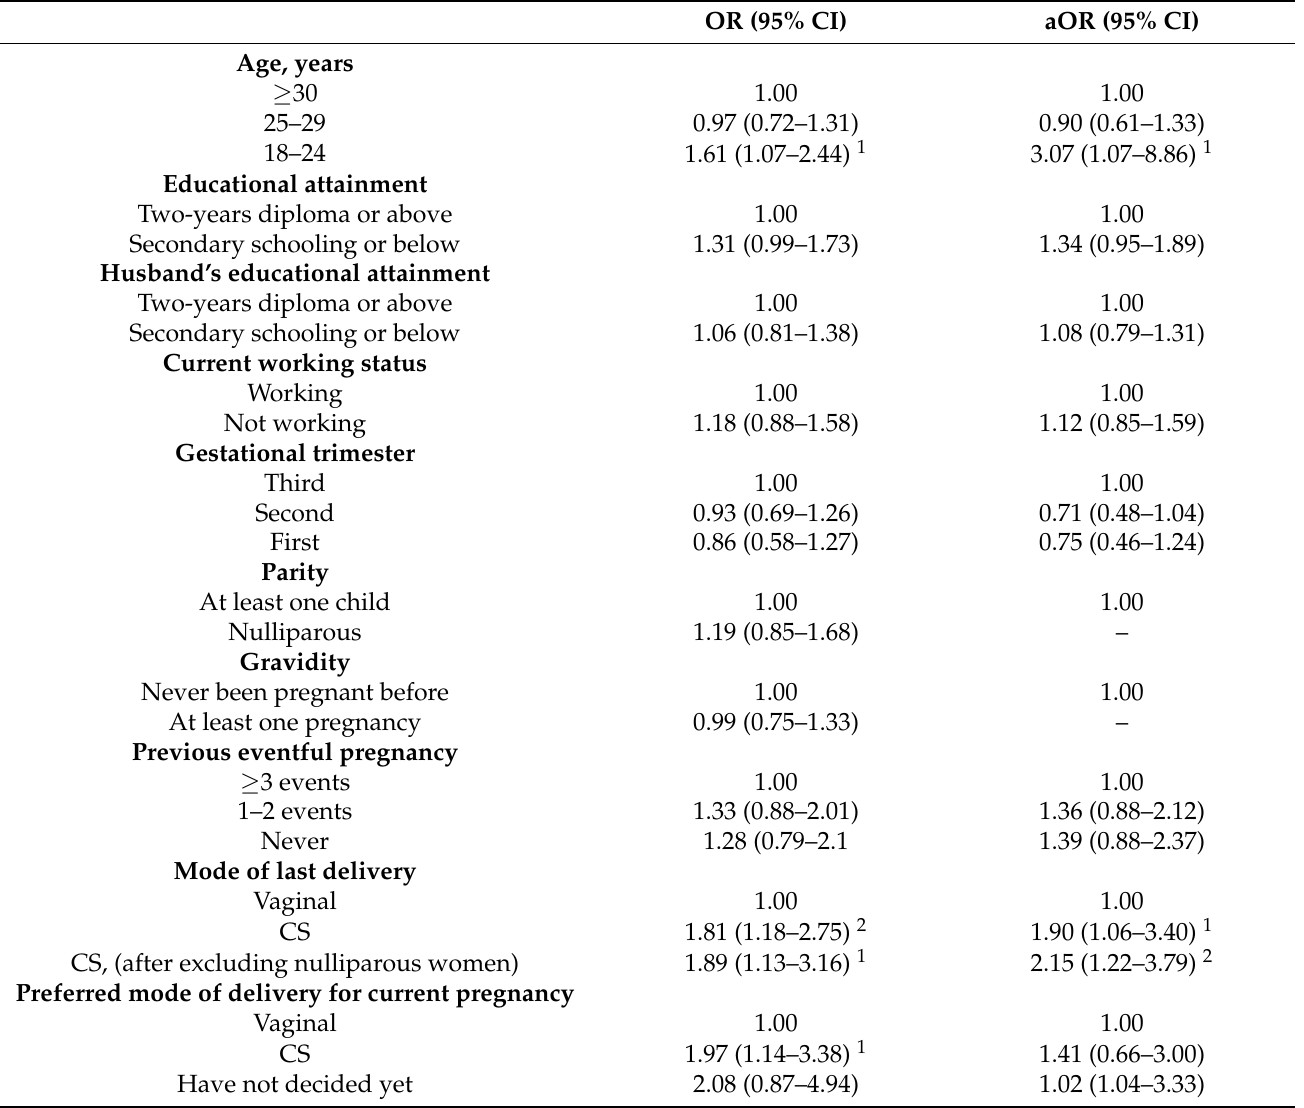
Figure 1. Comparison of knowledge towards mode of delivery among different women at different pregnancy trimesters ( p = 0.734). Table 3. Univariate and multivariate sociodemographic and maternal characteristics associated with a lack of adequate knowledge (score = 0–5) on CS